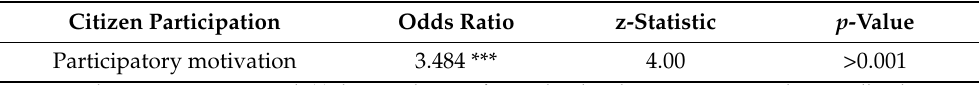
Table 6. Logistic regression: endorsement of citizen participation in RE projects.